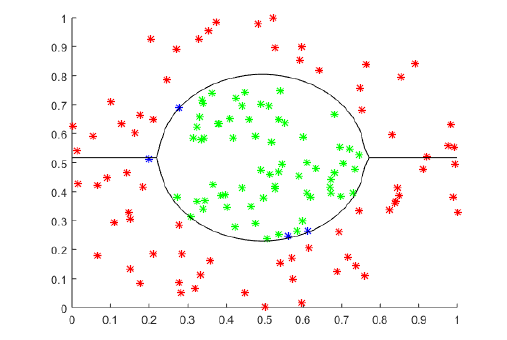
Fig. 3: First Classi(cid:28)cation using Gaussian Na(cid:239)ve